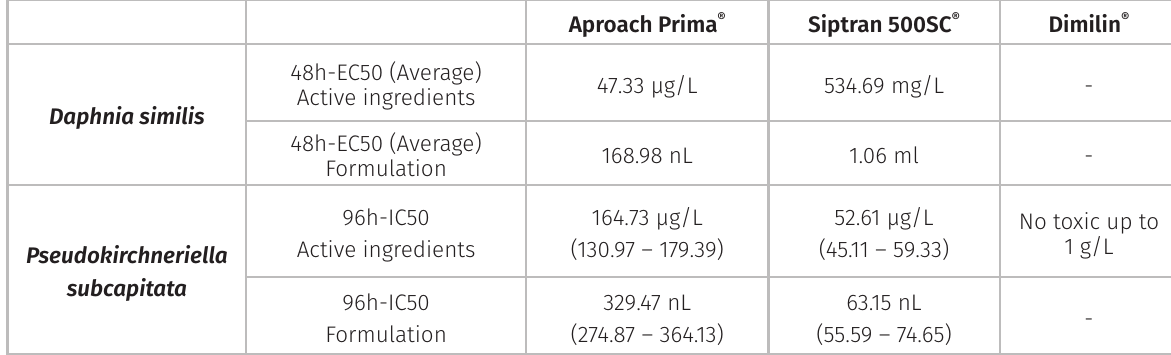
Table IV. 48h-EC50 and 96h-IC50 of three commercial pesticides to D. similis and P. subcapitata